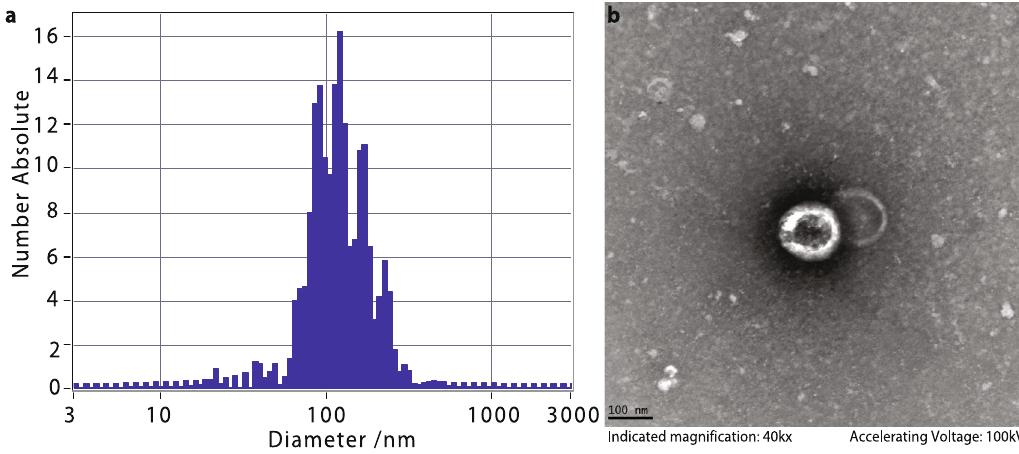
Figure 2. Extracellular vesicle profiles. ( a ) The EV size was profiled using ZetaView (Particle Metrix) with 10 median concentrations of 6.2 × 10 particles/ml with EV peak of 114.5 ± 4 nm . ( b ) EVs were imaged using transmission electron